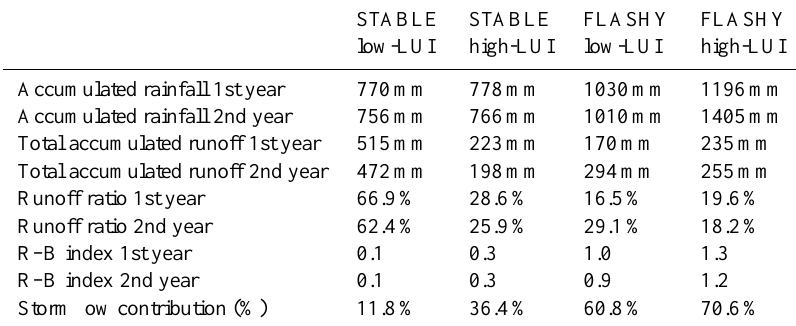
Table 2. Yearly accumulated rainfall and runoff in mm (direct measures), runoff ratio (percentage of rainfall water exported as runoff), and the R–B index (Richards–Baker index) of flashiness for each monitored year. Stormflow contribution: percent contribution of stormflow to total flow was estimated for the complete data set (2 years). STABLE: low-flashiness Danish streams; FLASHY: Uruguayan flashy streams; low- and high-LUI: low and high land use